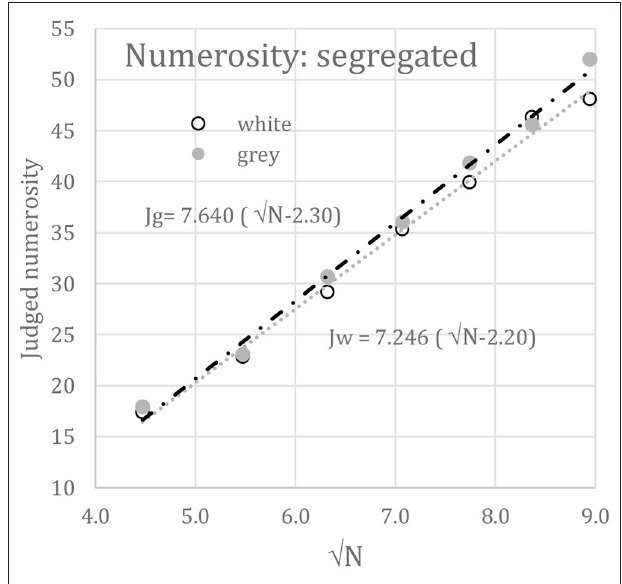
FIGURE 6 | Mean judged numerosity (J) vs. √ N when disk sets were segregated ; i.e., only white disks (Jw) or only gray disks (Jg) appeared on each